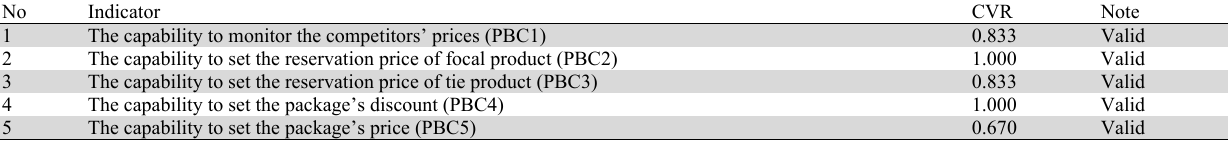
Content Validity of Pricing Bundling Capability